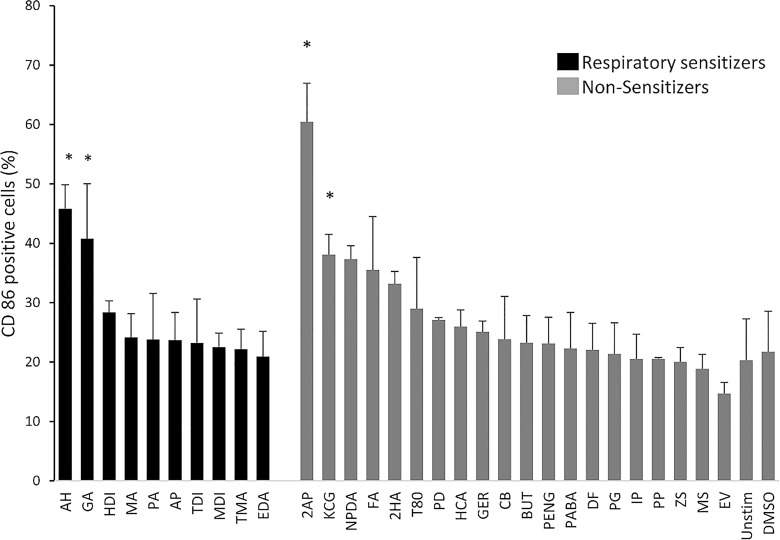
CD86 expression of MUTZ-3 cells following chemical stimulations.Data shown is an average of chemical stimulations, (n = 3), 4-Aminobenzoic acid, DMSO and unstimulated cells (n = 6) and potassium permanganate, 2-aminophenol, Hexylcinnamic aldehyde and 2-Hydroxyethyl acrylate (n = 2), with error bars showing standard deviation. Statistical significance was determined by student’s t-test, comparing each stimulation with its corresponding vehicle, with p < 0.05 indicated by *.